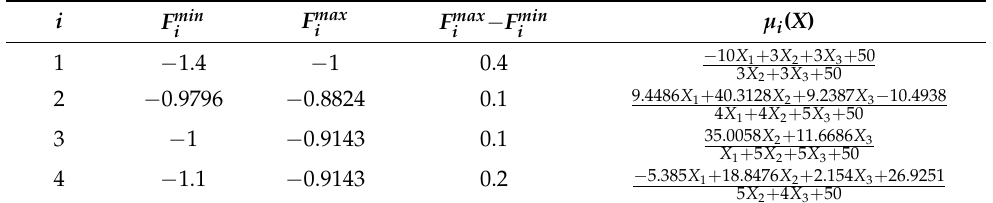
Table 1. Maxima and minima of F i ( X ) over feasible region S and the membership functions for (19).